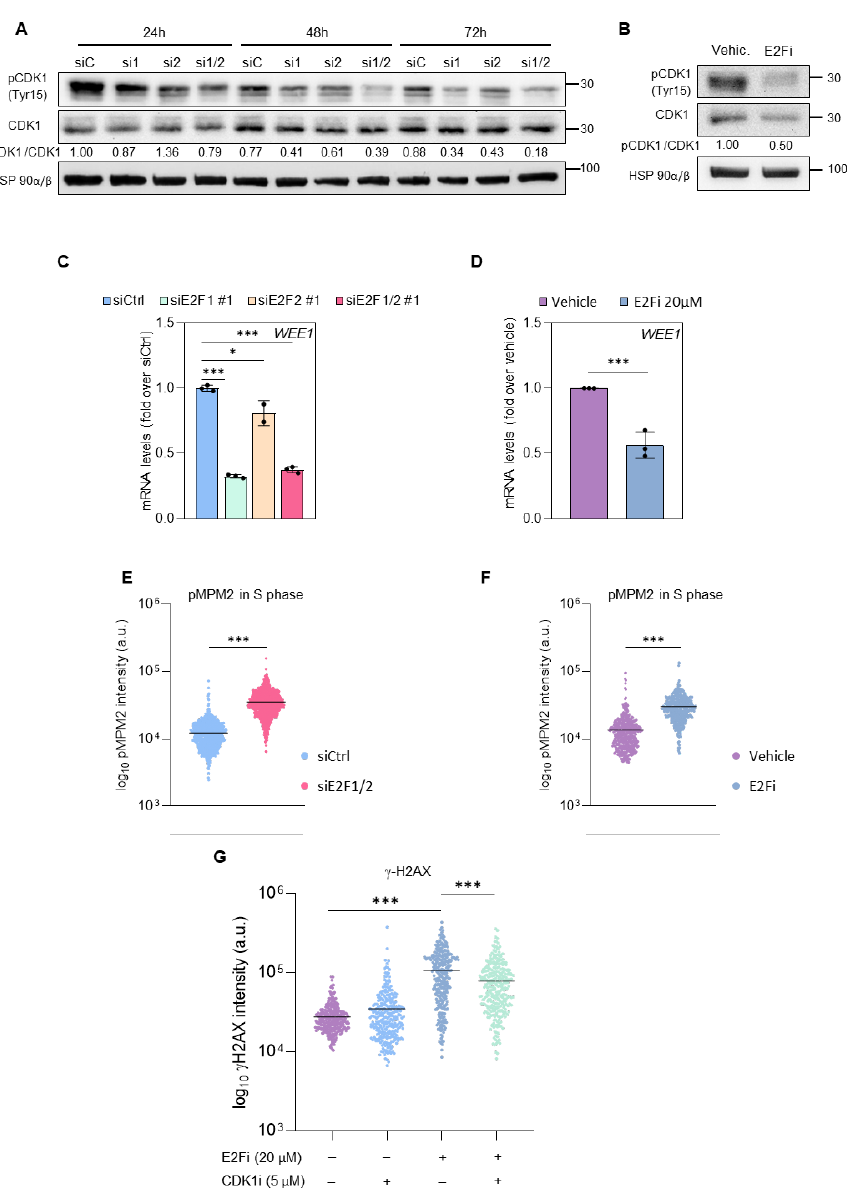
Figure 6. E2F1/2 knockdown or E2Fi increases CDK1 activity, and inhibition of CDK1 with RO3306 (CDK1i) prevents E2Fi-induced DNA damage in PC3 cells. ( A , B ) Representative Western blot analysis of CDK1 phosphorylated at Tyr 15 (pCDK1) and total CDK1 in extracts prepared from PC3 cells 24, 48 or 72 h after transfection with siCtrl, siE2F1#1, siE2F2#1, or siE2F1/2#1 ( A ) or treated with E2Fi (20 µ M) for 24 h ( B ). HSP90 was used as loading control. Densitometric values were used to calculate relative levels of pCDK1/CDK1, expressed as fold-over vehicle siCtrl ( A ) or vehicle ( B ) samples. ( C , D ) RT-QPCR analysis of WEE1 in PC3 cells 24 h after transfection with siCtrl, siE2F1#1, siE2F2#1 or siE2F1/2#1 ( C ) or 24 h after treatment with E2Fi 20 µ M ( D ). L19 mRNA was used as normalization control. Results are expressed as fold-over 24 h siCtrl, or vehicle (mean ± SD) from 1–3 independent experiments done in triplicate. ( E , F ) Intensity of pMPM2 signal in cells in S phase 72 h after transfection with siCtrl or siE2F1/2#1 ( E ), or 24 h after treatment with E2Fi (20 µ M, ( F )). Horizontal bars mark mean intensity. Data of 1000 cells from one representative experiment of 3 independent experiments are shown. ( G ) Intensity of γ H2AX signal in cells in S phase 24 h after the indicated treatments. Data are expressed as Log10 intensity. Horizontal bars mark median intensity. Data of 300 cells from one representative experiment of three independent experiments are shown. Statistical analysis was performed using ANOVA and Fisher’s test. *** p < 0.0001, * p <